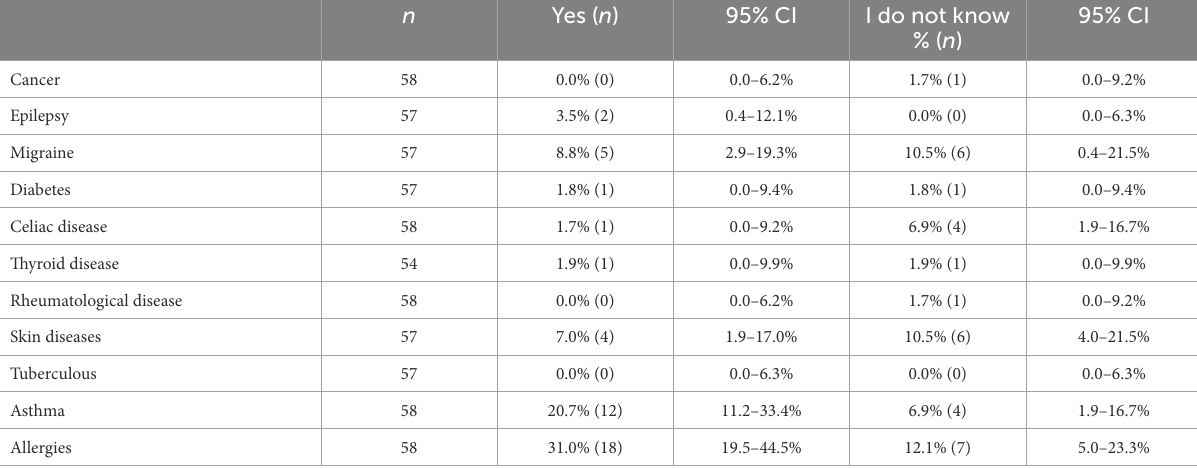
TABLE 1 Prevalence of somatic diseases in the multinational sample of gender non-binary adolescents ( N =